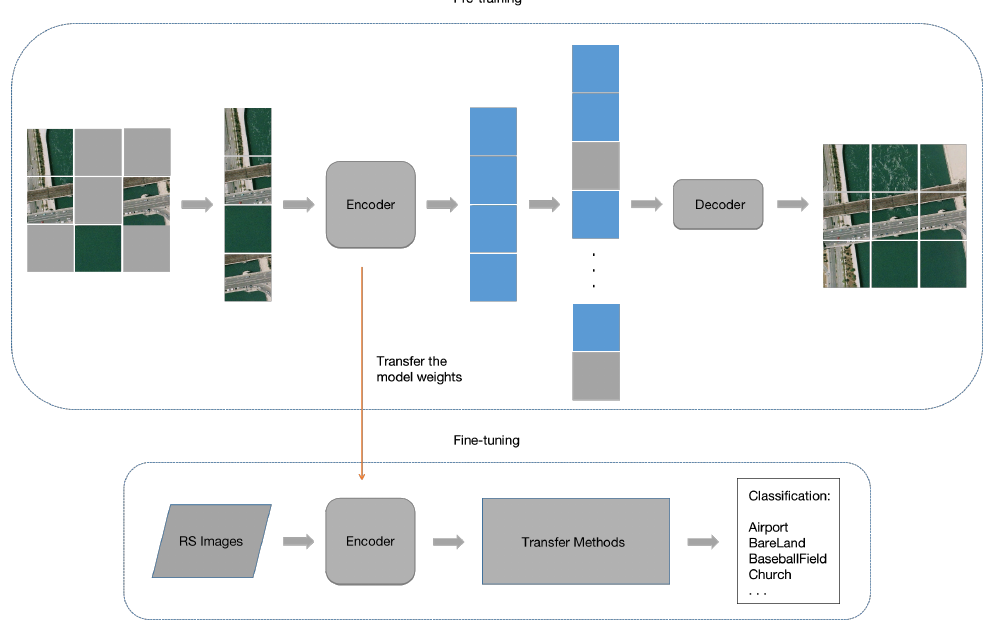
Figure 2. Our self-supervised learning training process.